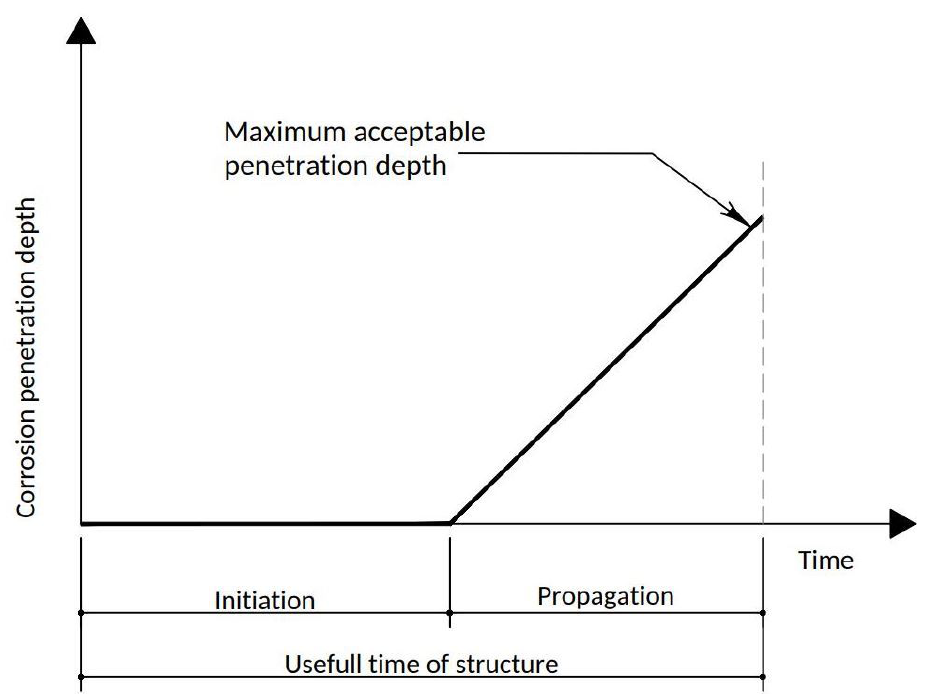
Figure 1. Initiation and propagation periods for corrosion in a reinforced concrete structure (Tuutti model)